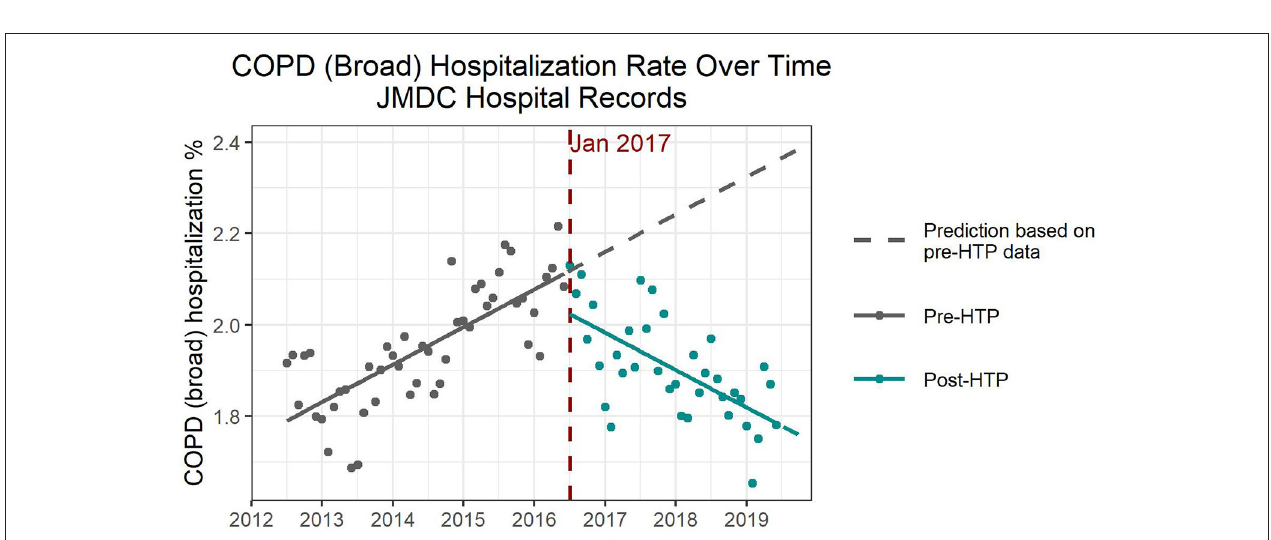
FIGURE 2 | Expected and observed trends in hospitalization numbers due to chronic obstructive pulmonary disease after introduction of heated tobacco products in Japan.